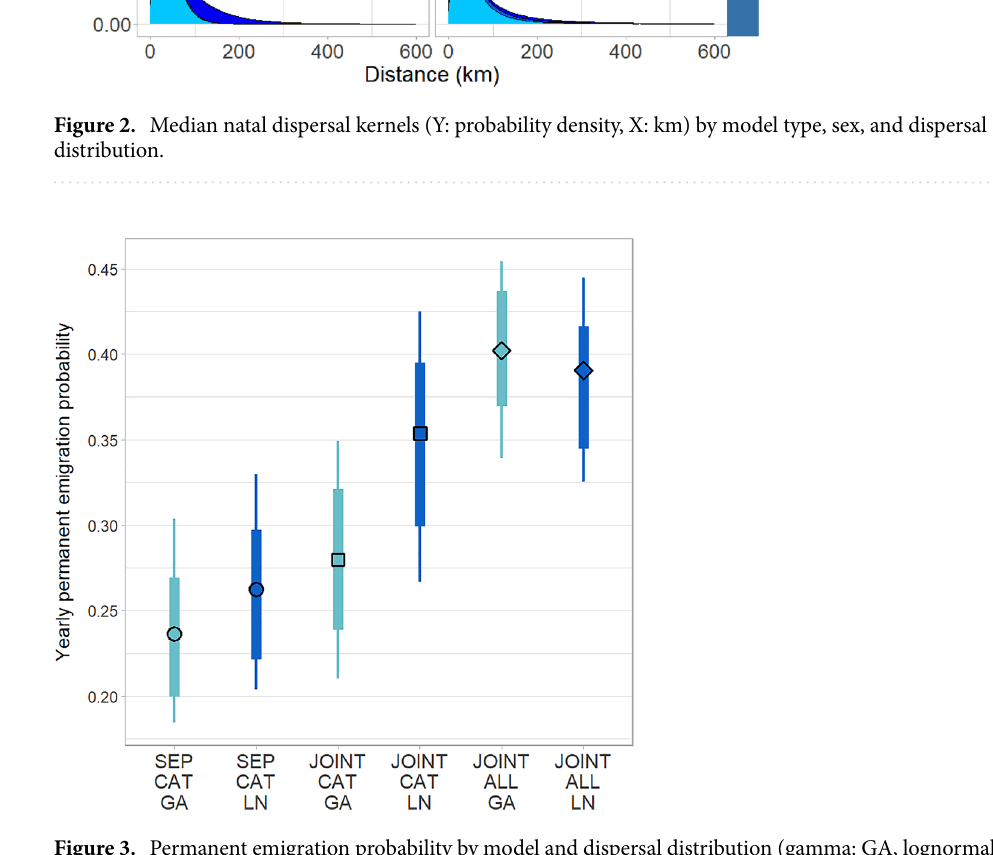
Figure 3. Permanent emigration probability by model and dispersal distribution (gamma: GA, lognormal: LN). Circles and squares indicate median values. Thick lines indicate the 66% HPDI and fine lines show the 89%